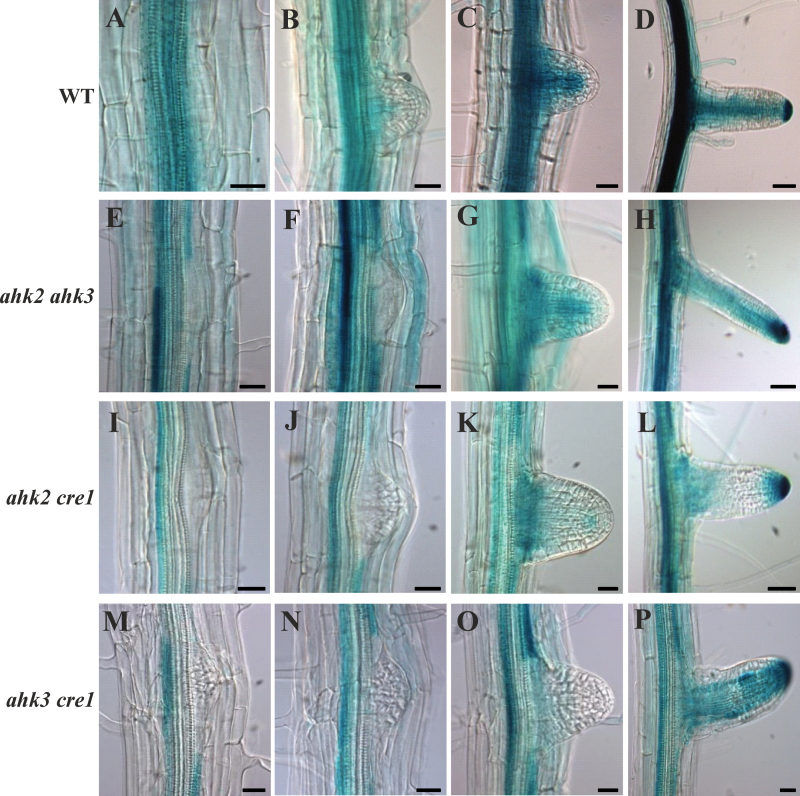
Expression of ARR5:GUS in the wild type and cytokinin receptor mutants during LR formation. ARR5:GUS expression is indicated by blue staining in LRs of different stages (from left to right: early, late, emerged, mature) in the wild type (A–D), and ahk2 ahk3 (E–H), ahk2 cre1 (I–L), and ahk3 cre1 (M–P) mutants. Eleven-day-old Arabidopsis seedlings were incubated in staining solution for 6h. Typical staining patterns are shown for each genotype and stage (n=20). Bar in (A–C, E–G, I–K, M–P)=20 μM; bar in (D, H, L)=50 μM.